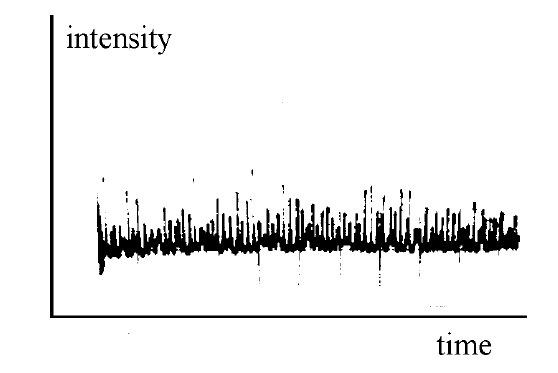
Figure 1. High-frequency pulsating oscillations in the maser output. Adapted with permission from Figure 2b of [5] c (cid:13) The Optical